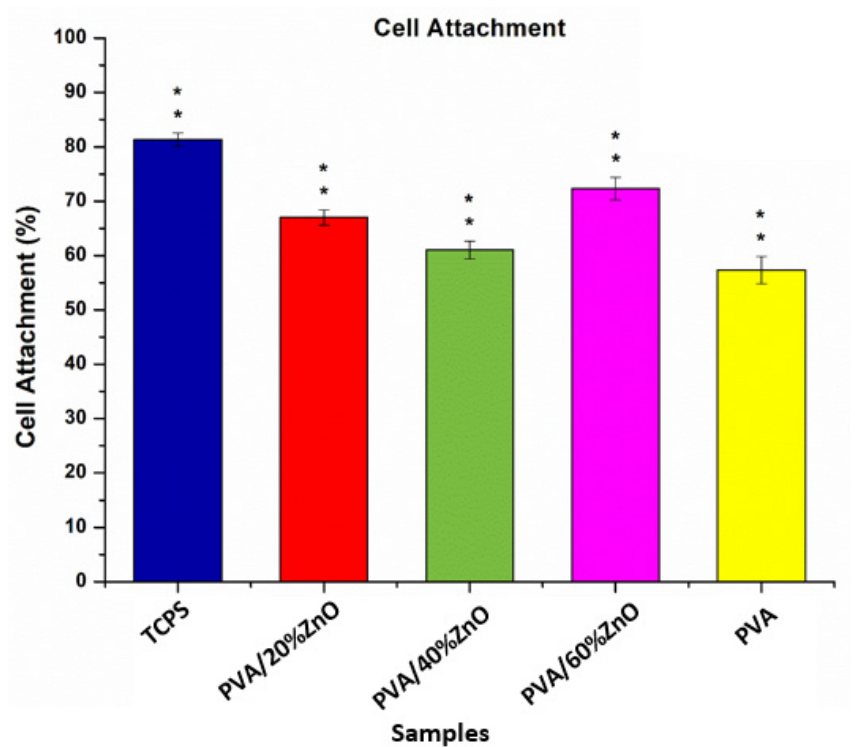
Figure 7. Percentage of cell attachment on the TCPS as control and electrospun fibers. Statistical significance ‘ p ’ is shown as p < 0.05 = ‘*’ and p < 0.01 = ‘**’.